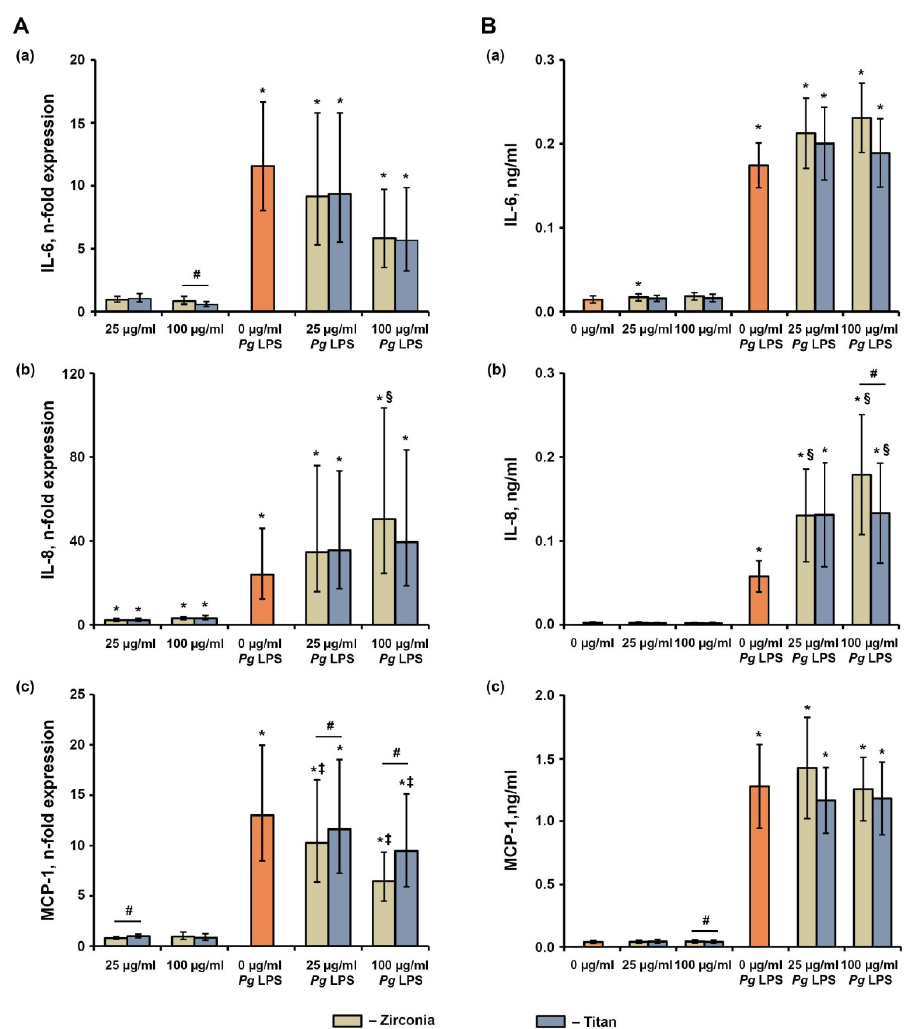
Figure 7. The effects of different NPs on the P. gingivalis LPS-induced response in hG-MSCs. The hG-MSCs were stimulated with P. gingivalis LPS (Pg LPS) in the absence or in the presence of different NPs for 24 h. The resulting gene expression ( A ) and protein production ( B ) rates for IL-6, IL-8, and MCP-1 were determined via qPCR and ELISA, respectively. ( A ) Y-axis represents n-fold expression of target genes in hG-MSCs cultured under various conditions in relation to cells cultured without NPs and Pg LPS, calculated using the 2 −ΔΔCt method, using GAPDH as a reference gene. ( B ) Y-axis shows the concentrations of various proteins in the conditioned media measured. Data are presented as means ± s.e.m. of six independent experiments performed with hG-MSCs isolated from six different donors. Note: *—significantly higher compared to control, p < 0.05; #—significantly different between Ti NPs and Zr NPs, p < 0.05; §—significantly higher compared to Pg LPS without NPs, p < 0.05; ‡—significantly lower compared to Pg LPS without NPs, p <